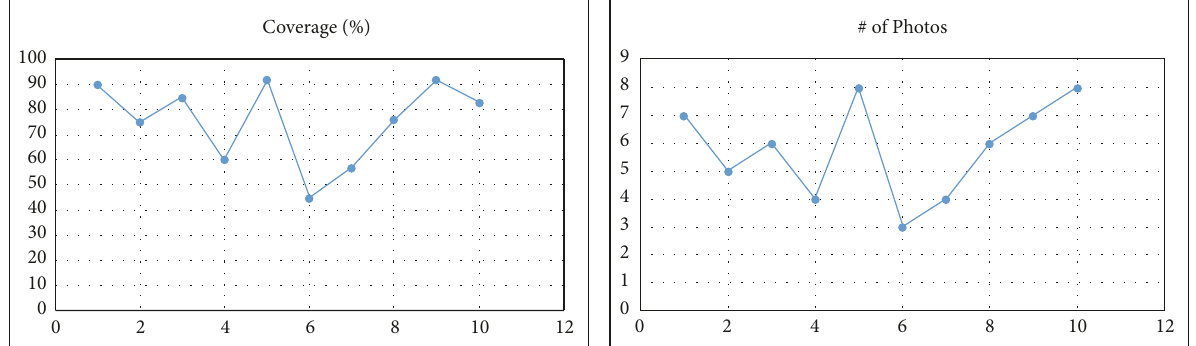
Figure 12: Percent coverage and photo taking results.